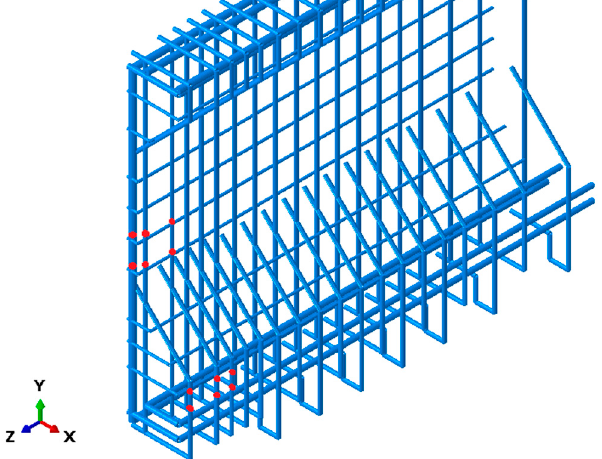
Figure 5. Position of the strain gauges (indicated with red dots).